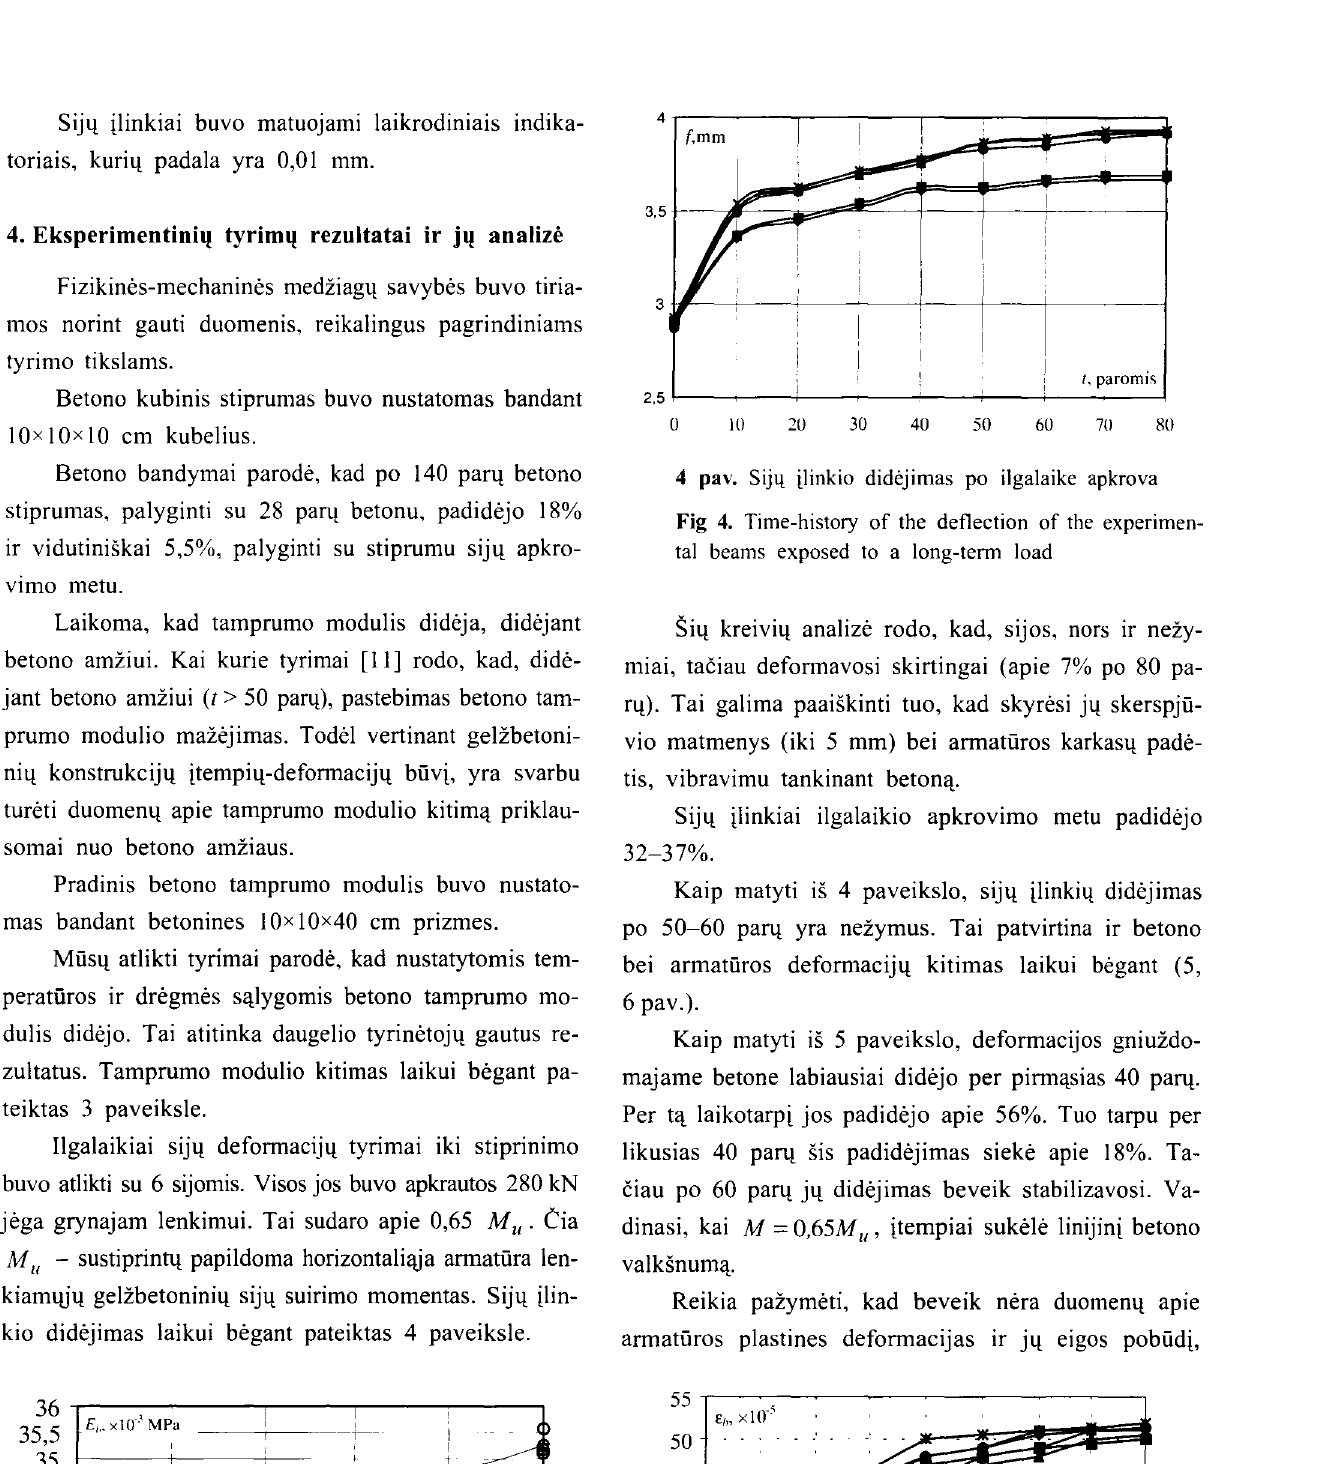
Fig 5. Time-history of the concrete strain in the com pressive zone of